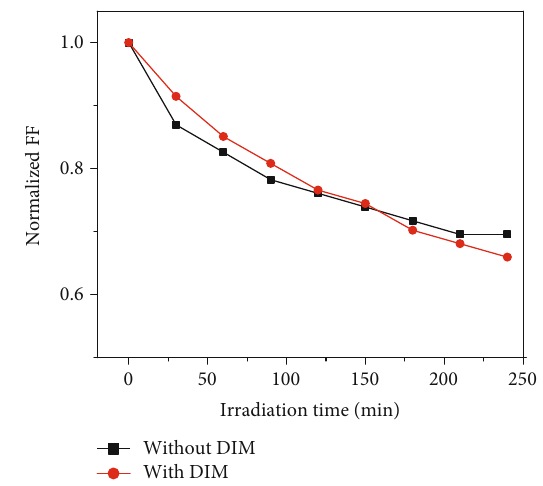
Figure 9: Normalized FF of the PCDTBT:PC processed without and with 3% DIM as a function of irradiation (100mW/cm 2 ) time at ambient